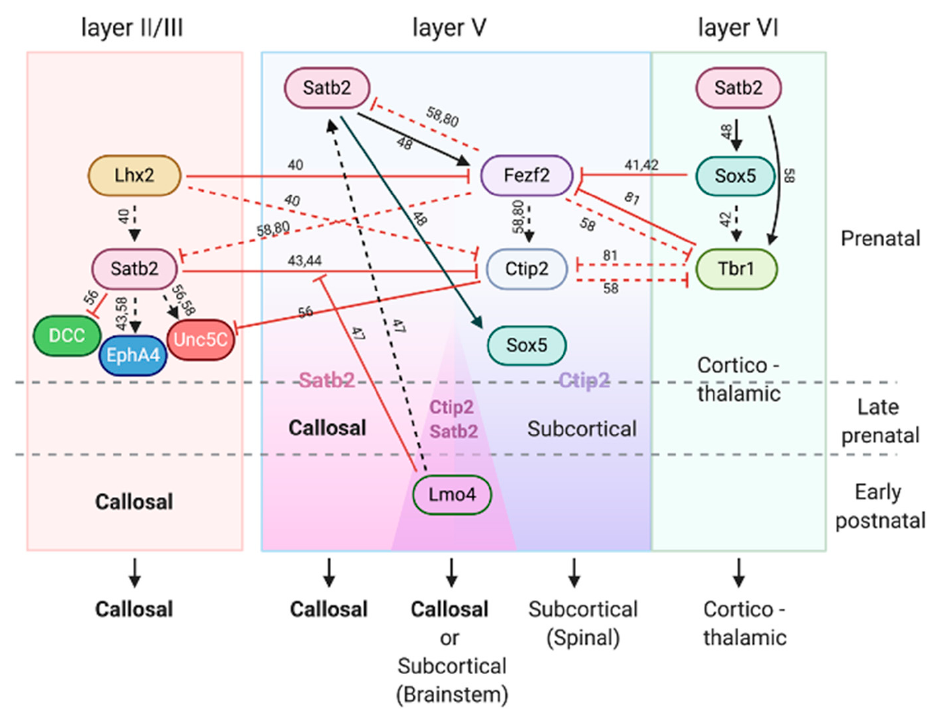
Figure 2. Interactions between key transcription factors and axon guidance molecules for CPN specification. SATB2-associated interactions during prenatal period define TBR1 + corticothalamic projection neurons in layer VI, SATB2 + CPNs in layer II/III, as well as SATB2 + CPNs and CTIP2 + subcortical (spinal) projection neurons in layer V. LMO4 further specifies CPNs or subcortical (brainstem) projection neurons from SATB2 + /CTIP2 + populations during the early postnatal period in layer V. Regular arrows and flat-headed arrows indicate positive and negative regulations. Continuous lines indicate direct regulations, while dashed lines indicate suggested interactions demonstrated by knockout mouse and/or in utero electroporation experiments. Reference numbers supporting each interaction are indicated.